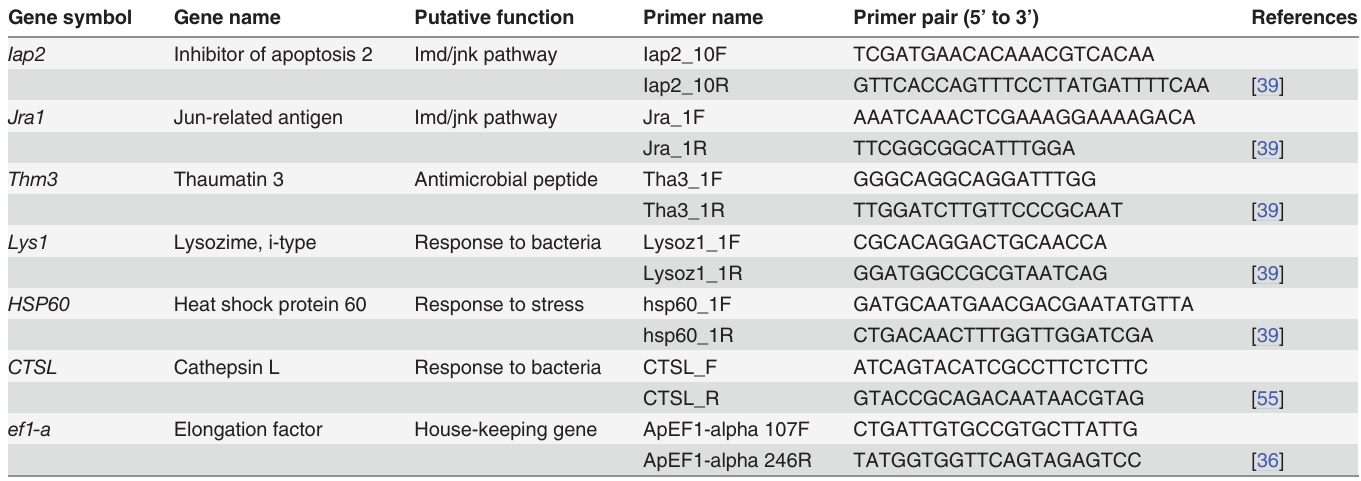
Table 1. List of genes and primers used in the study for quantitative PCR analyzed by quantitative real-time RT-PCR analysis. Gene